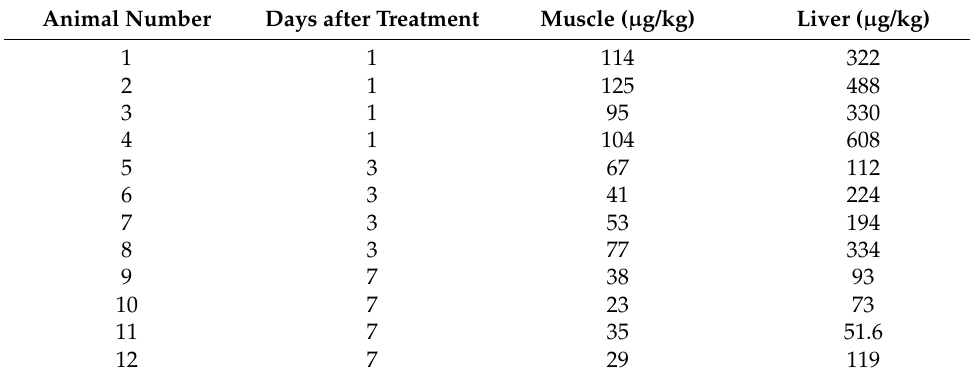
Table 2. Values found in pigs for tiamulin marker residues (dose 12,000 µ g tiamulin/kg body weight/day for 7 days).